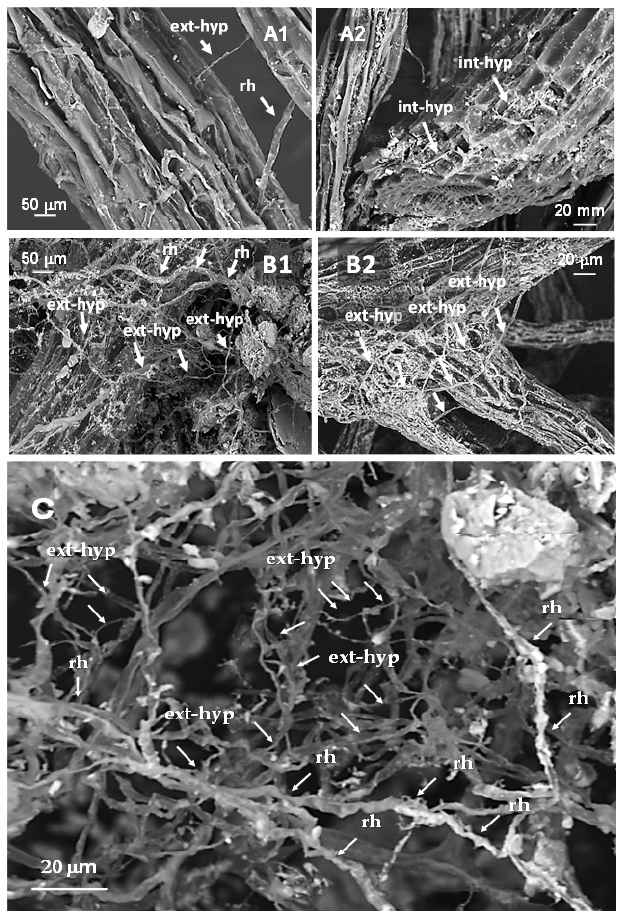
Figure 2. SEM-back-scattered electrons detection (BSE) images of fine lateral roots of Cucumis melo in No agroecological service crops (ASC) ( A1,A2 ) and Yes ASC-wheat ( B1,B2 ) systems, and mycorrhizal network developed on melon roots grown on flattened wheat ( C ). int-hyp: AMF internal hyphae; ext-hyp: AMF extra-radical hyphae; rh: root hairs. A1–B1: magnification = 200x; A2–B2: magnification = 700x; C: magnification = 1.5KX.